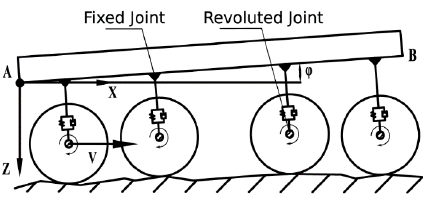
Figure 2. Simplified vehicle model for the dynamics analysis.